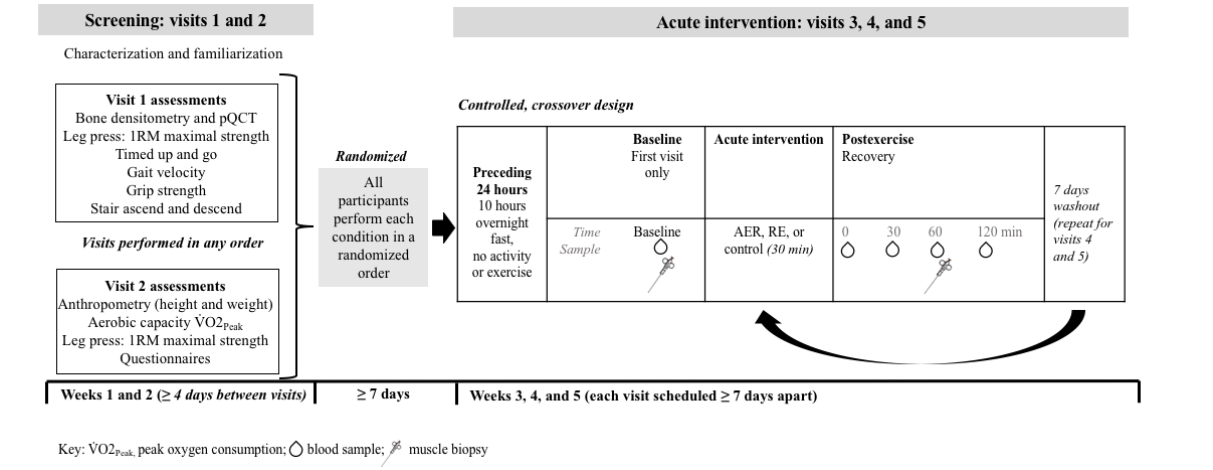
Figure 1. Study design. 1RM: one-repetition maximum; AER: aerobic exercise; pQCT: peripheral quantitative computed tomography; RE: resistance